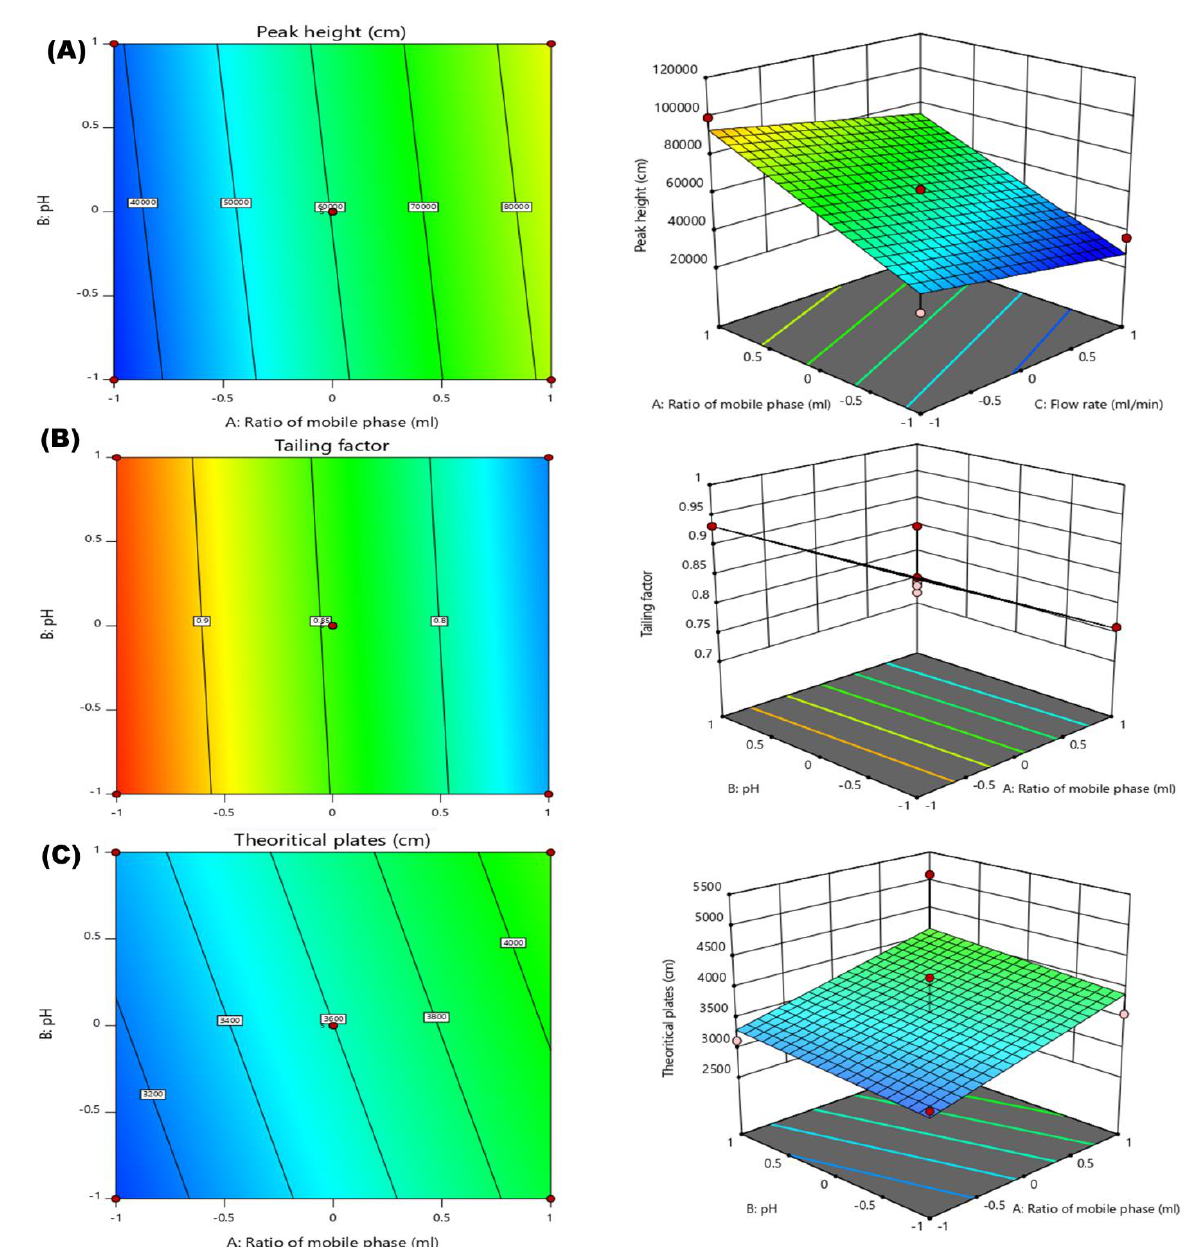
Figure 3. ( A ) 2D and 3D response surface plots representing the effect of factors Mobile phase ratio (A), pH of 0.1% OPA (B) and Flow rate (C) on Peak height(R3). ( B ) 2D and 3D response surface plots representing the effect of factors Mobile phase ratio (A), pH of 0.1% OPA (B) and Flow rate (C) on peak Tailing factor(R4). ( C ) 2D and 3D response surface plots representing the effect of factors Mobile phase ratio (A), pH of 0.1% OPA (B) and Flow rate (C) on Theoretical plates(R5).